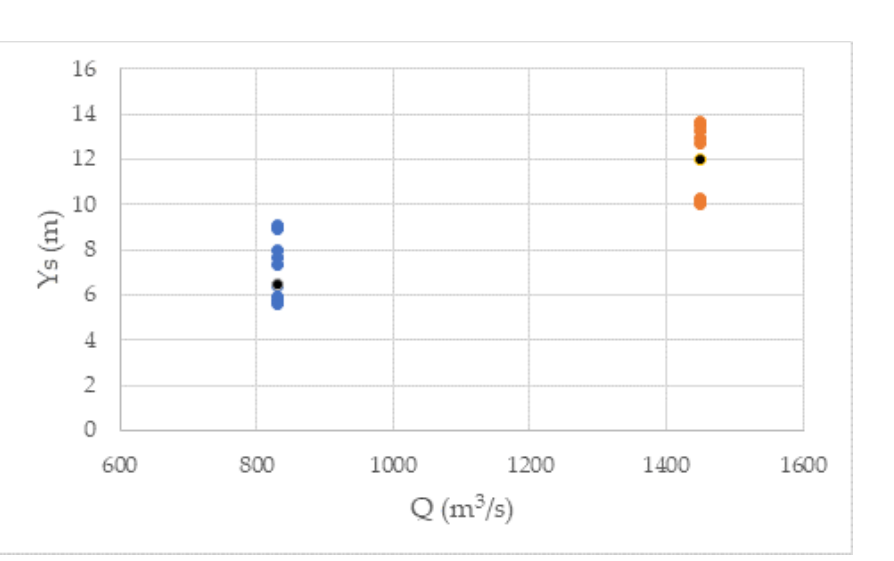
Figure 12. Hydrodynamics in the stilling basin and in the riverbed downstream from the lateral view for Test #3a (ski jump like sill in place) and Test #3b (ski jump like sill removed).